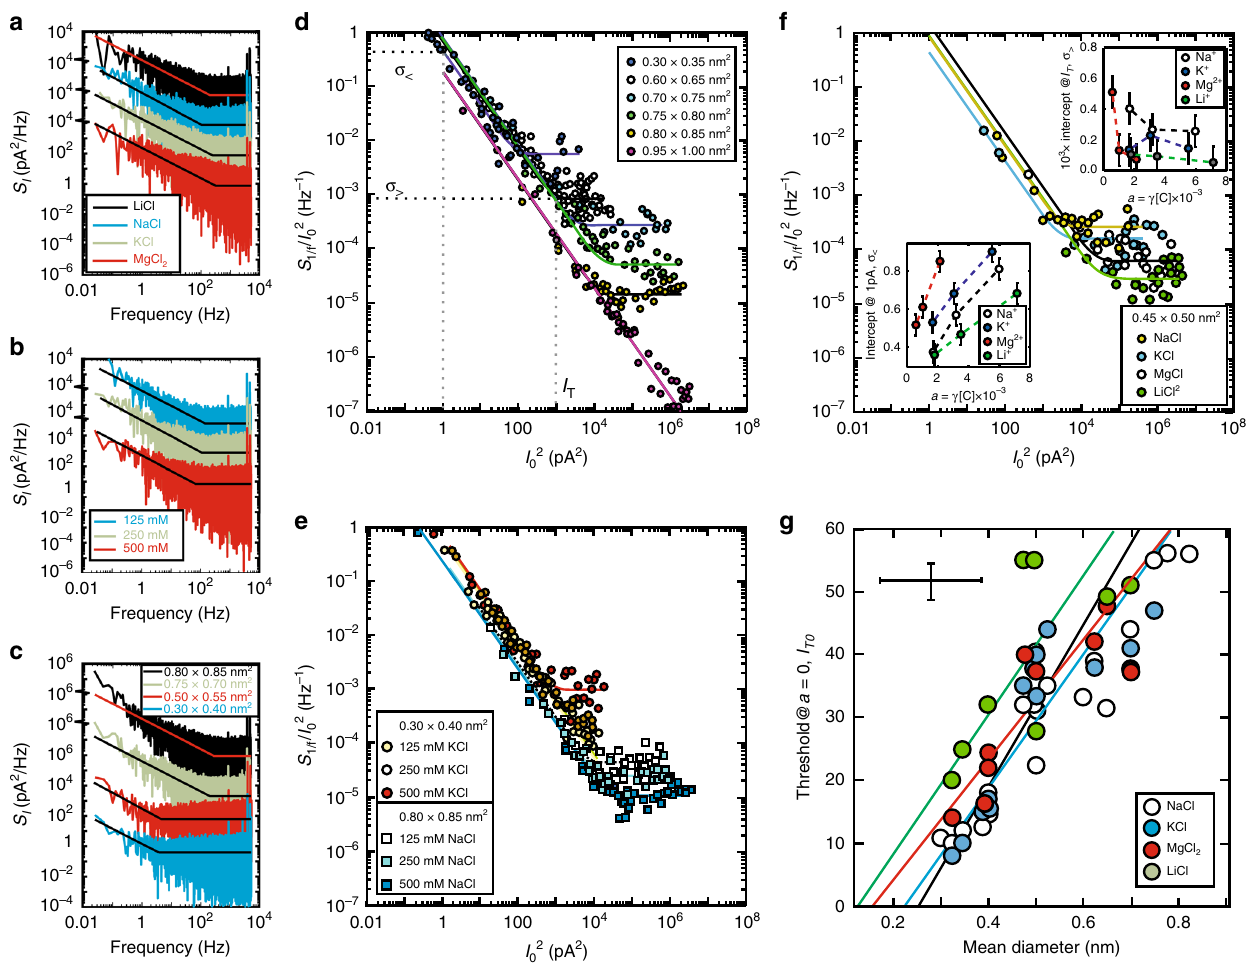
Fig. 4 Correlated current noise in sub-nanopores. a The noise power spectral densities (PSDs) acquired from a sub-nanopore with a mean-diameter of 0.72 nm at the waist, at about the same pore current ( I 0 = 370 – 465 pA) for four different electrolytes at 250 mM. The spectra are offset for clarity. b Like a , the PSDs acquired from the same sub-nanopore at about the same open pore current ( I 0 = 410 – 440 pA) for three different concentrations of NaCl. c Like a , the PSDs acquired from four different pores with mean-diameters of (0.30 nm × 0.40 nm → )0.35 nm, (0.50 nm × 0.55 nm → )0.52 nm, (0.70 nm × 0.75 nm → )0.72 nm, and (0.80 nm × 0.85nm → )0.82 nm, measured in 500 mM KCl. d The noise PSD intercept at 1 Hz ( S 1/f ), normalized by the square of the open pore current, I 2 , measured in 500 mM NaCl, plotted as a function of I 2 for sub-nanopores with mean-diameters ranging from (0.30 nm × 0.35 0 0 nm → )0.32 nm to (0.95 nm × 1.00 nm → )0.97 nm. The normalized noise power for I 0 < 10 pA was generally consistent with noise resulting from uncorrelated current fl uctuations. However, beyond the threshold current de fi ned by I T , for the 0.288 nm-diameter pore, S I = I 2 is independent of the current 0 indicating correlations between fl uctuations. The solid lines represent fi ts to the data. The (black) dotted lines represent the extrapolations from the fi ts to I 2 the intercepts σ < and σ > at which S I = I 2 reaches 1 pA (below threshold, left vertical gray dotted line) and S I = I 2 at threshold (right vertical gray dotted line). 0 0 0 e Like d , but for two different electrolytes at three concentrations, using respectively two different pores: one with a (0.30 nm × 0.40 nm → )0.35 nm (top) and another with a (0.80 nm × 0.85 nm → )0.82 nm mean-diameter (bottom). f Like d , but for four different electrolytes at 500 mM concentration for a sub-nanopore with a (0.45 nm × 0.50 nm → )0.47 nm mean-diameter. g The dependence of the threshold current extrapolated to zero-activity, I T0 , on the mean-diameter of the pore is shown for four different electrolytes. The best- fi t lines extrapolate to diameters for Li + , Mg 2 + , Na + , and K + of 0.13 ± 0.11 nm, 0.16 ± 0.11 nm, 0.22 ± 0.11 nm, and 0.25 ± 0.11 nm, respectively, consistent with estimates derived from the conductance. The error bars represent